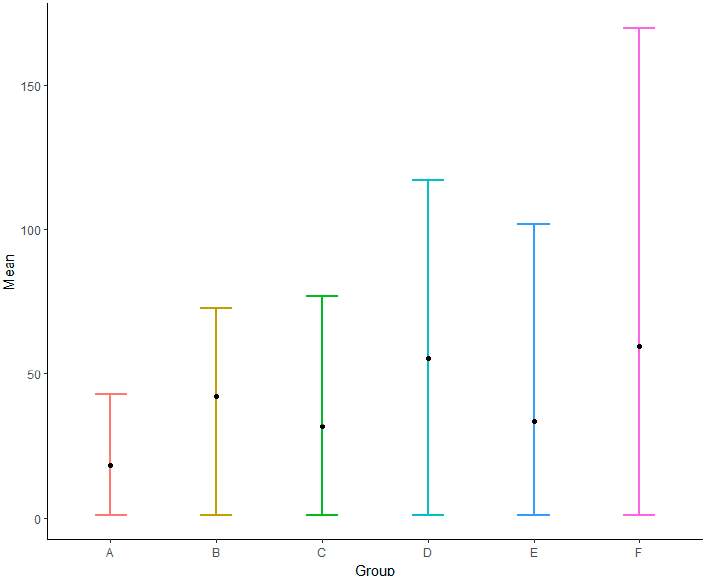
Figure 5. Figure 5. Mean effect size with 95% confidence intervals for the number of species with correlation relationships.